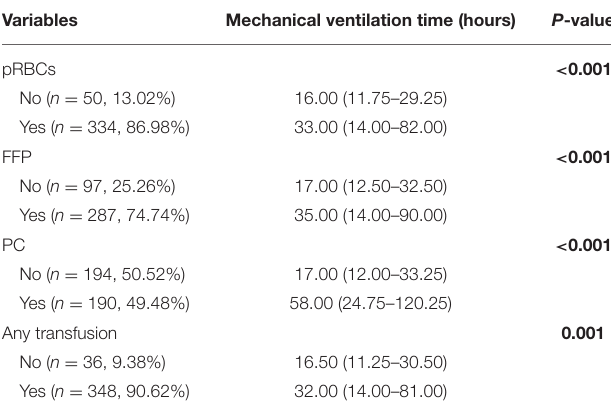
TABLE 2 | Differences in MVT after different blood products transfusion.